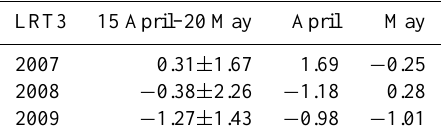
Table 5. (left) Springtime (15 April–20 May) mean ± 1 σ LRT3 index (Liang et al., 2005) averaged from daily values and (right) monthly mean LRT3 values for both April and May from